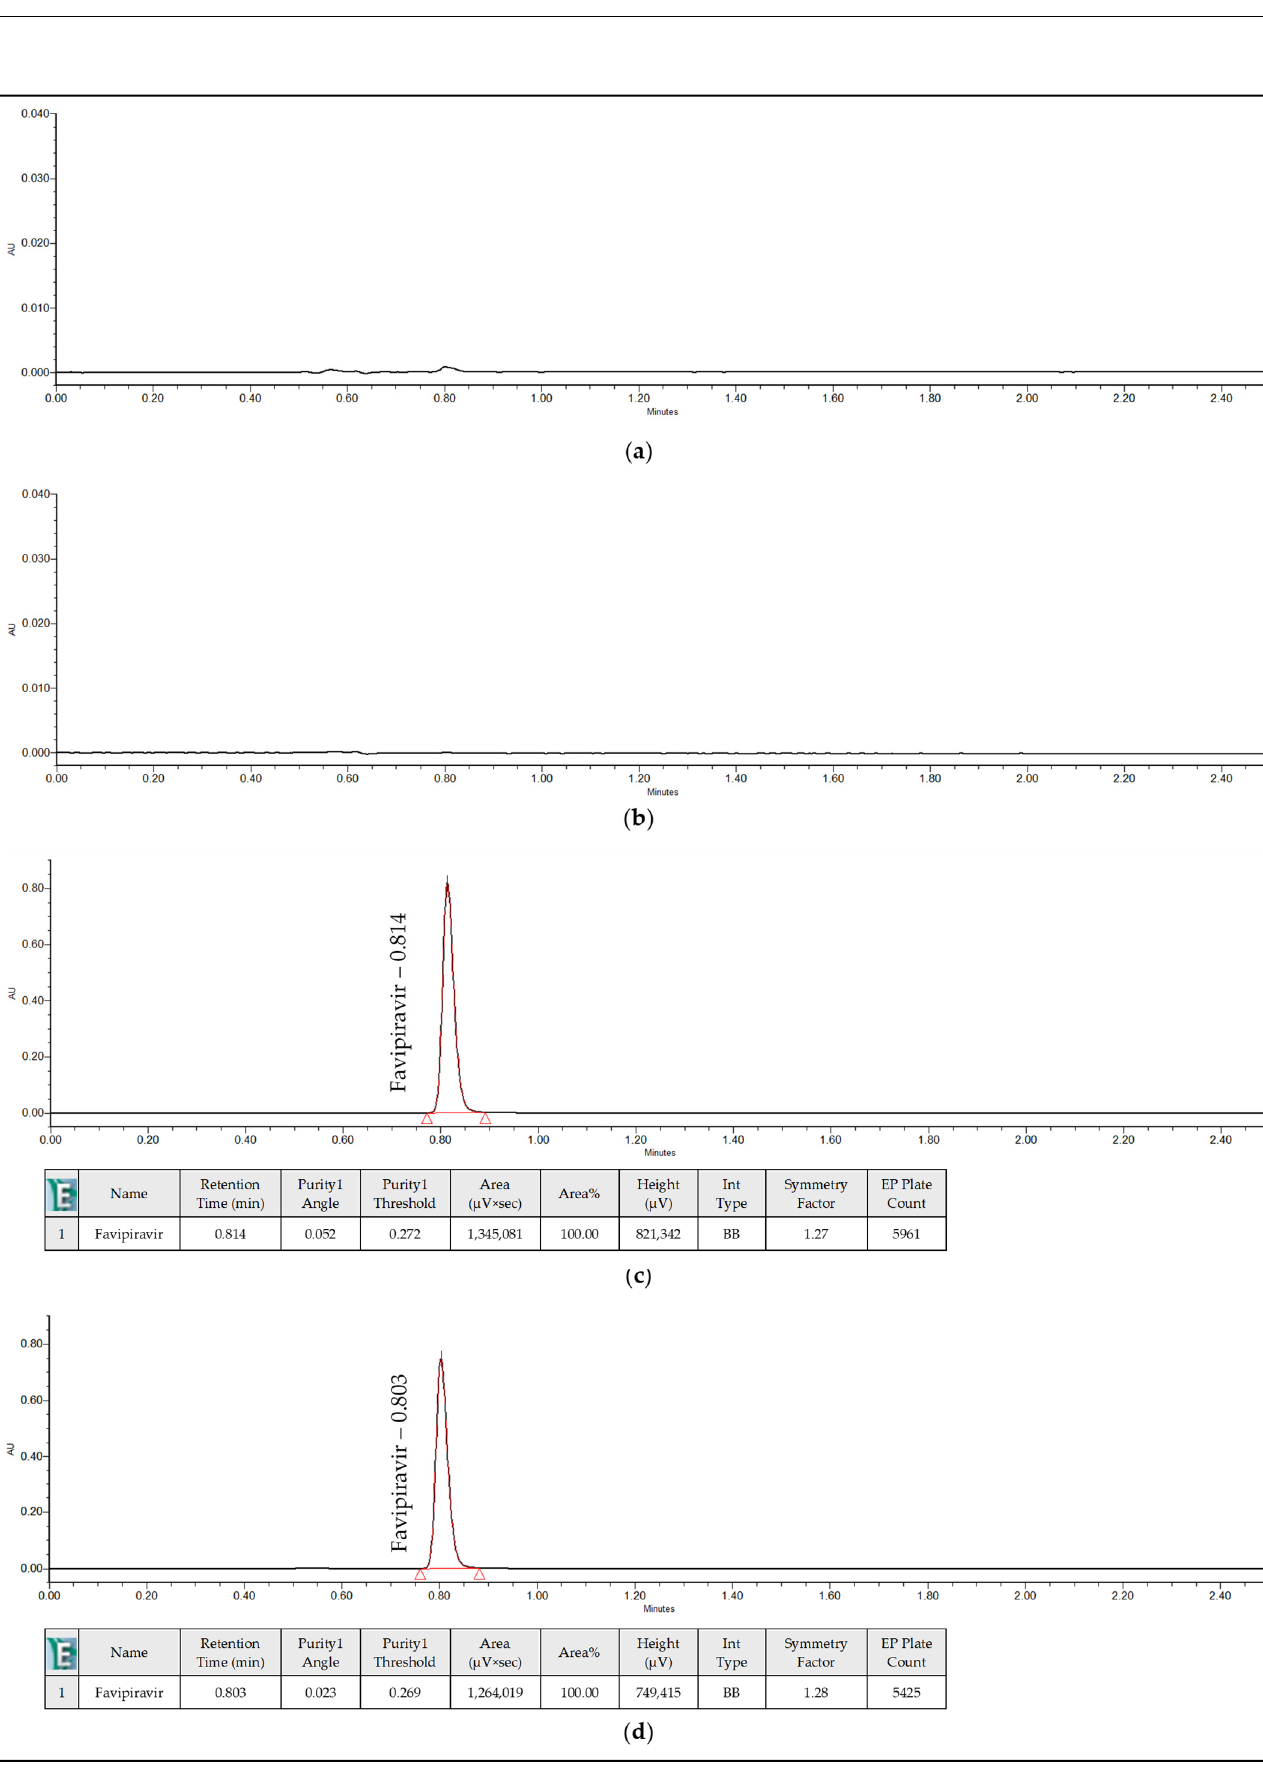
Figure 4. Selectivity Chromatogram: ( a ) Blank solution; ( b ) Placebo solution; ( c ) Standard solution; ( d ) Sample solution.